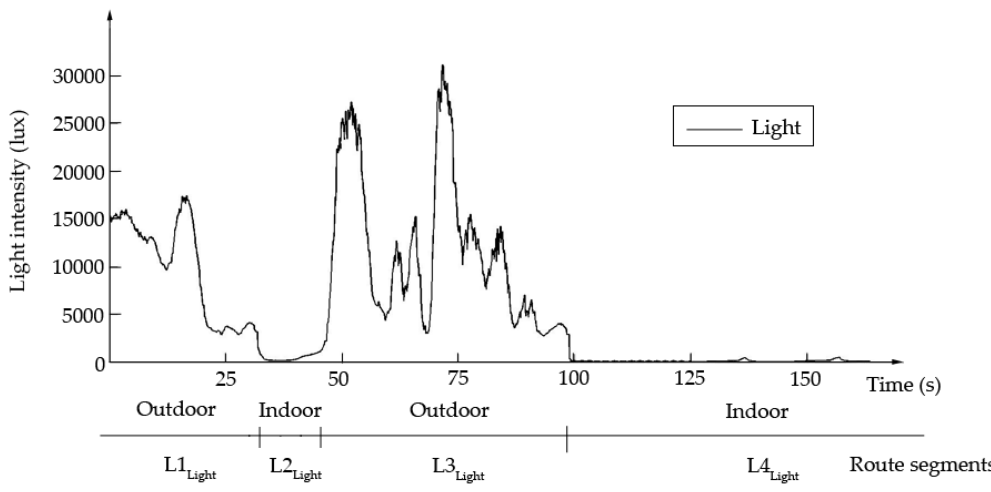
Figure 4. Light data.